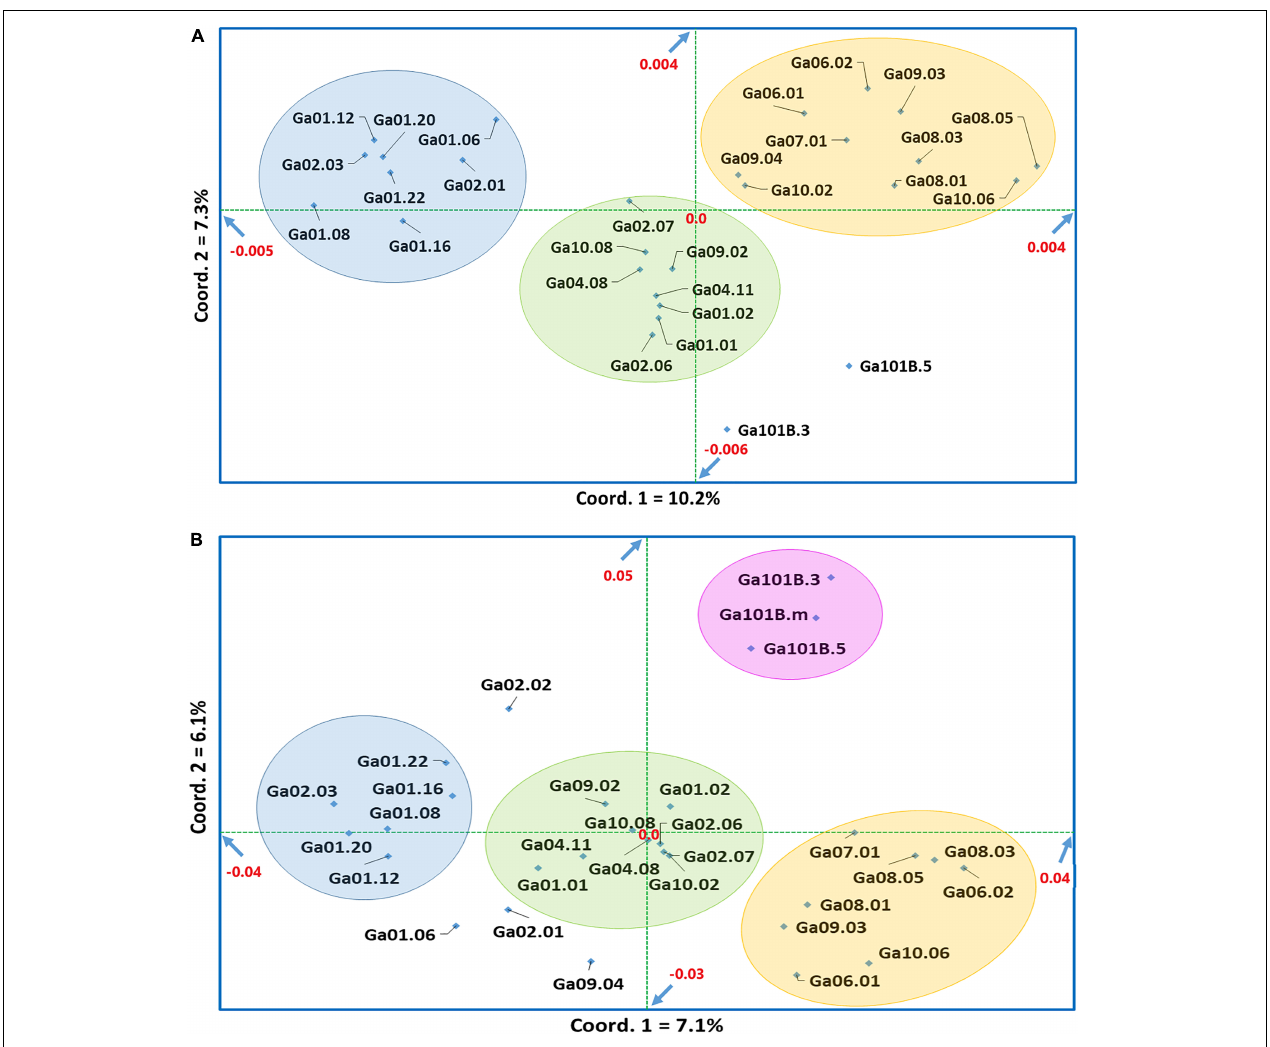
FIGURE 6 | Principal coordinate analysis (PCoA) of (A) 28 noug genotypes and (B) 30 noug genotypes based on Nei’s standard genetic distances calculated using genotypic data at 5,531 and 1,687 SNP loci, respectively. The first two principal coordinates together explained 17.5 and 13.2% of the total variation in the case of panels (A,B) ,